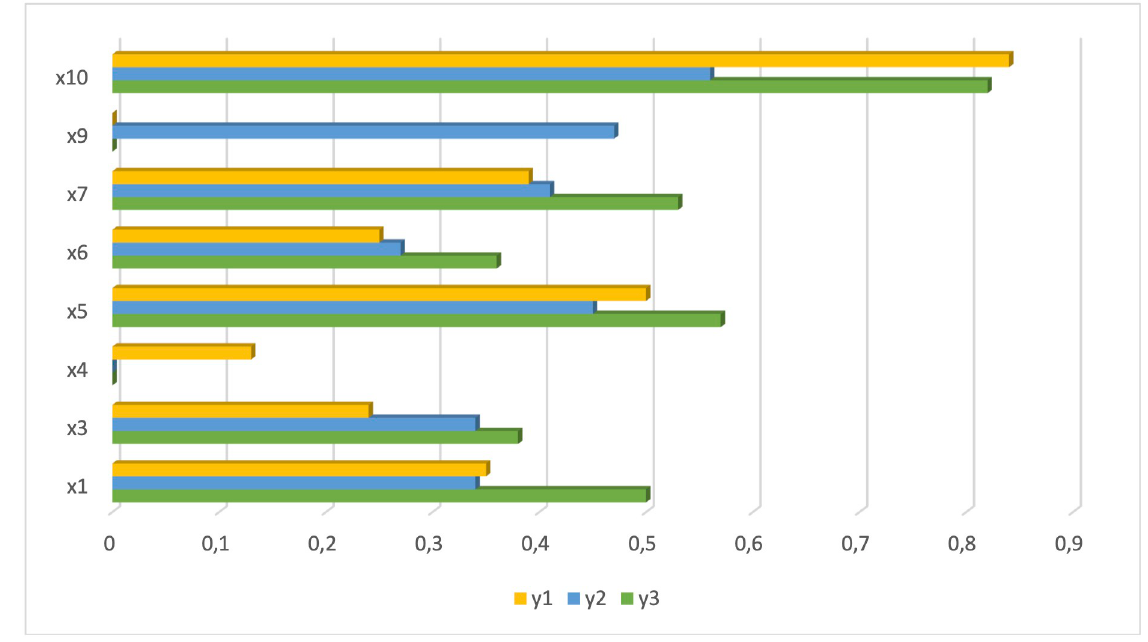
Fig 2. Odds ratio for statistically significant variables for all logistic regression